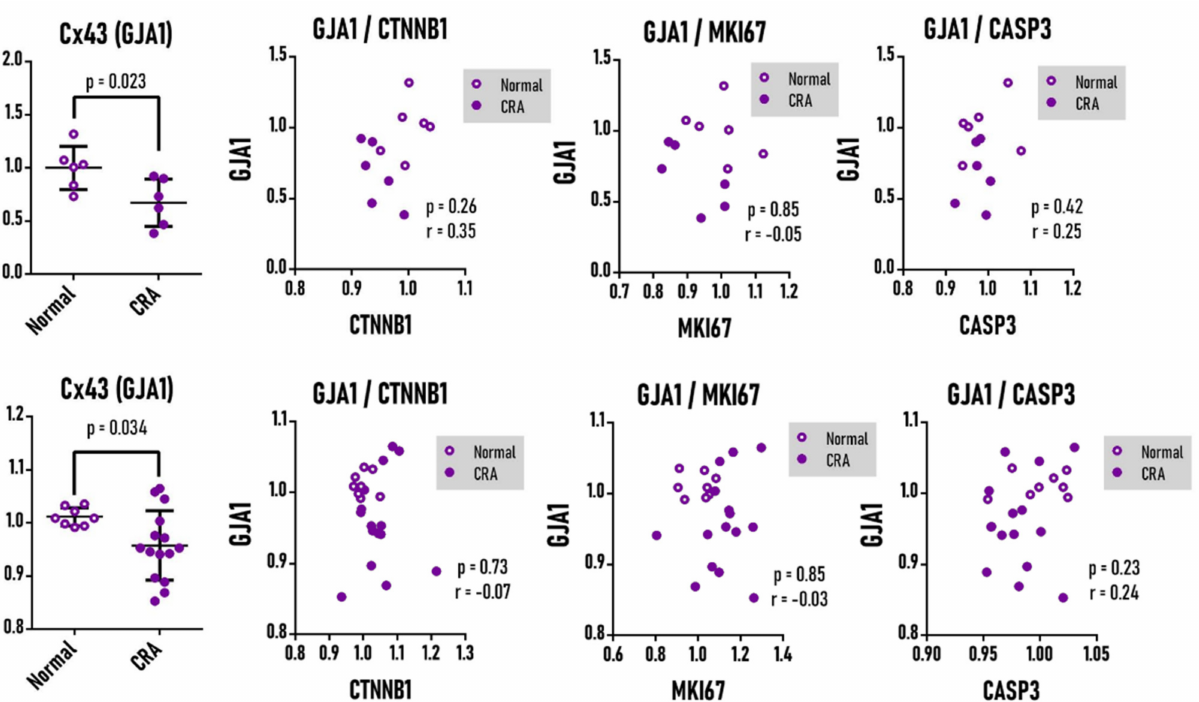
Figure 6. In silico analysis of the Cx43 gene (GJA1) and its correlation with the β -catenin (CTNNB1), Ki-67 (MKI67), and caspase-3 (CASP3) mRNA levels in colonic human samples ( A ) laser microdis- sected or ( B ) whole biopsy samples of a normal mucosa/colon and colorectal adenoma (CRA). A: human normal mucosa and CRA samples ( n = 6 for each class); B: normal colon ( n = 8) and CRA ( n = 15) samples. Data were presented as mean ± standard deviation and data points. Data were analyzed by the Student’s t -test or Pearson’s correlation test ( p <